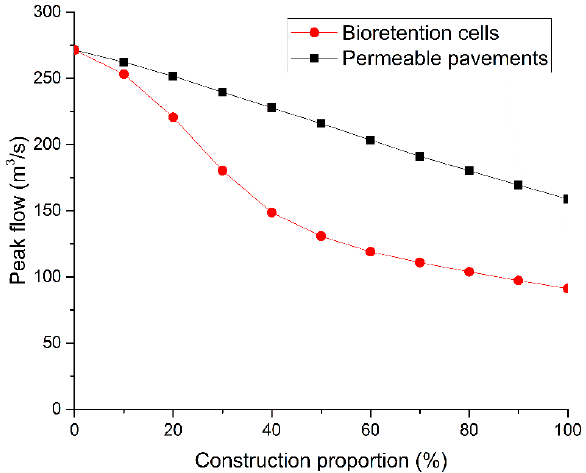
Figure 12. Peak value of outlet flow with different construction proportion of LID controls ( p = 10